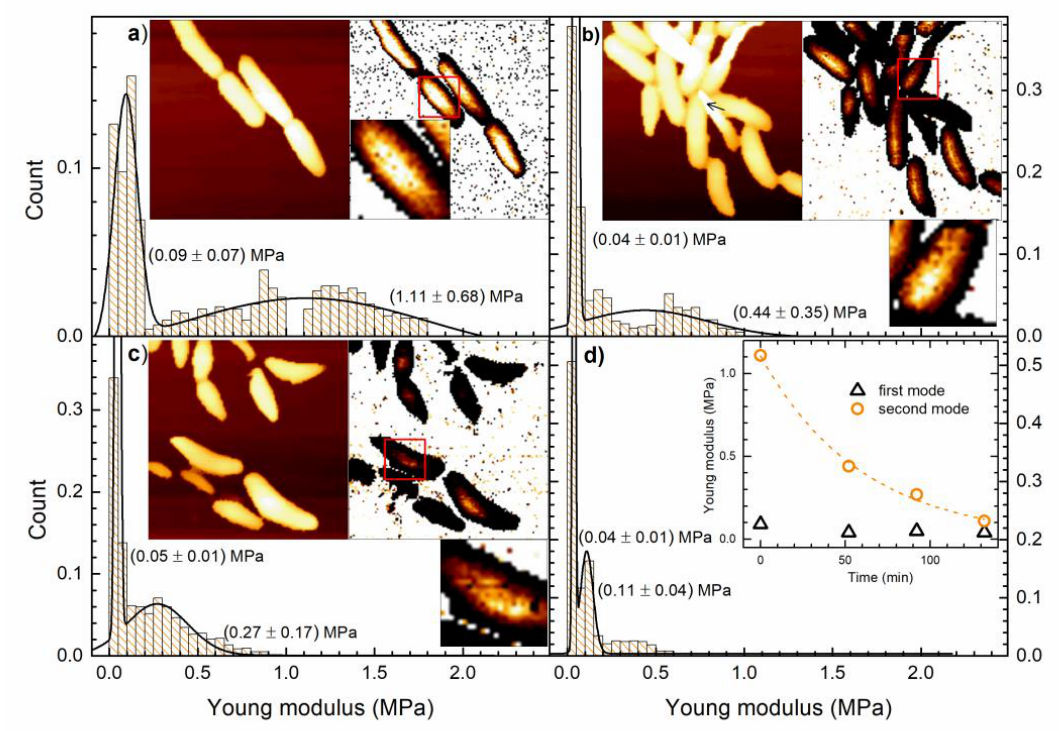
Figure 4. AFM data of non-treated and AgNPs treated E. coli cells at di ff erent times . Topography and YM maps are obtained for the same cell group and the data are collected at di ff erent pre- and post-treatment times. Larger images have 128 × 128 resolution, 10 × 10 µ m scan size, 0 to 1.5 µ m height color scale, and 0 to 1 MPa YM color scale. Histograms, representing count versus Young modulus, are the distributions of the YM data selected within the 5% of the highest points for each scan line. The full lines are the bimodal normal distribution fits with means and the standard deviations given in parentheses. Parts of the YM maps marked with red squares are enlarged. ( a ) Non-treated bacterial cells height data (left image) and the corresponding calculated YM data (right image). ( b ) Treated bacterial cells height data (left image) and the corresponding calculated YM data (right image) whose scan began after 50 min of treatment. ( c ) The same as in ( b ) with the scan beginning after 90 min of treatment ( d ) The same as in ( b ) with the scan beginning after 130 min of